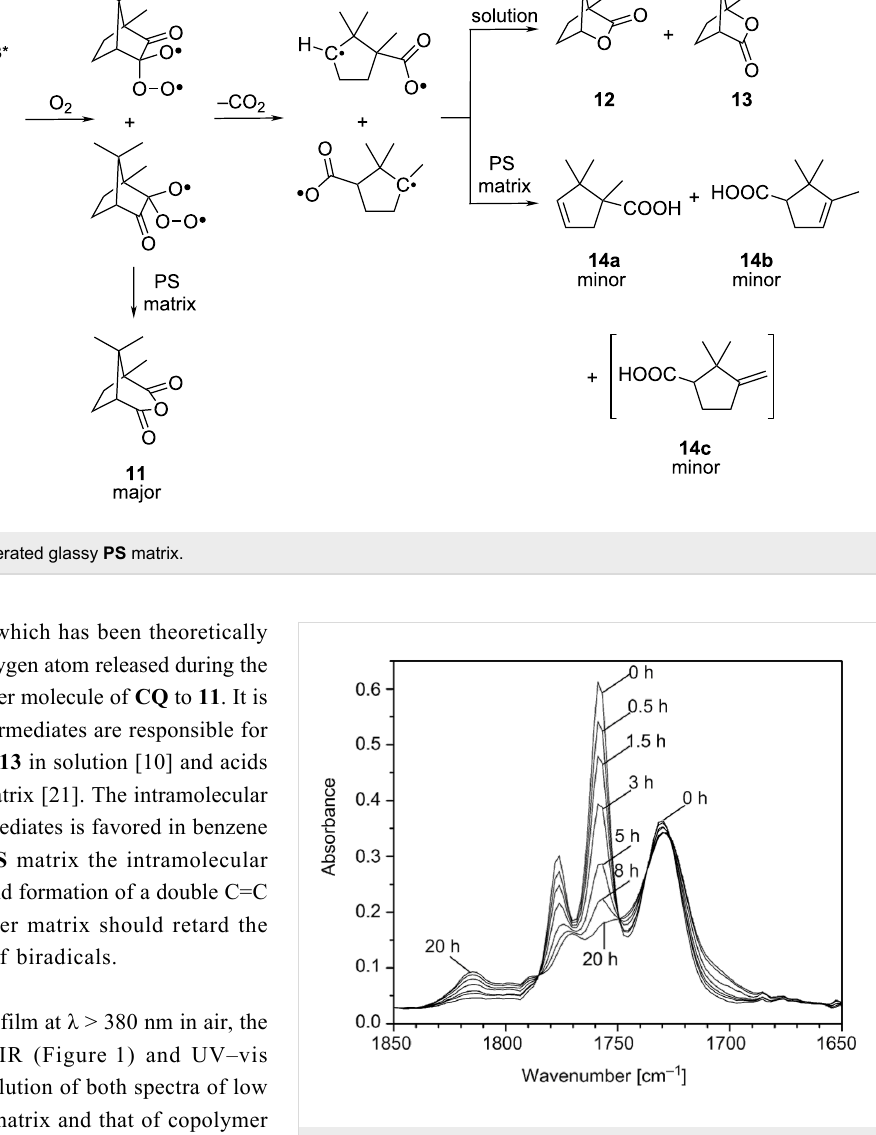
reduction of the n →π * absorption band of the 1,2-dicarbonyl group of the CQ structure is seen. The GC–MS results [21] allow the rough estimation of the distribution of CQ photooxidation products in PS from the GC record. About 54% of the whole area corresponds to 11 and its secondary products formed during isolation (secondary prod- ucts are not formed in the MCQ/S film during irradiation). 16% corresponds to 14a – c and the remaining 30% are unidentified compounds. A similar distribution of products is most probably also present in the photooxidized MCQ/S